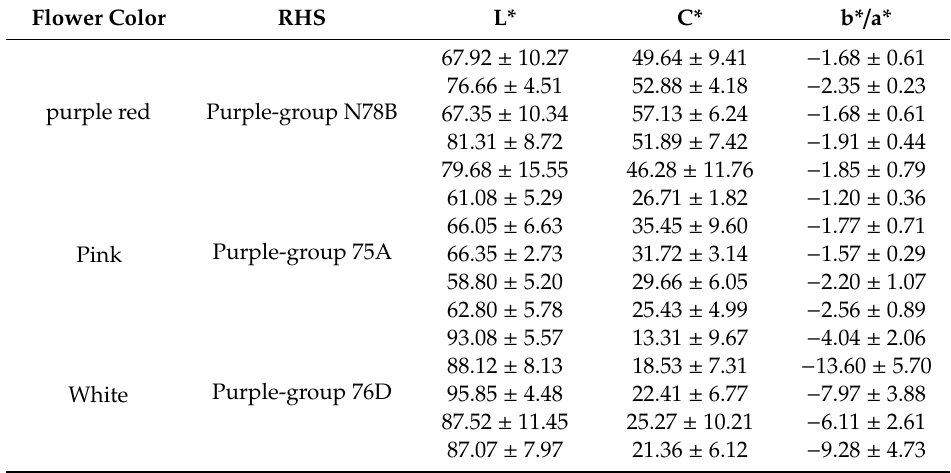
Table 2. Color parameters of three distinct colors of P. limprichtii petal.